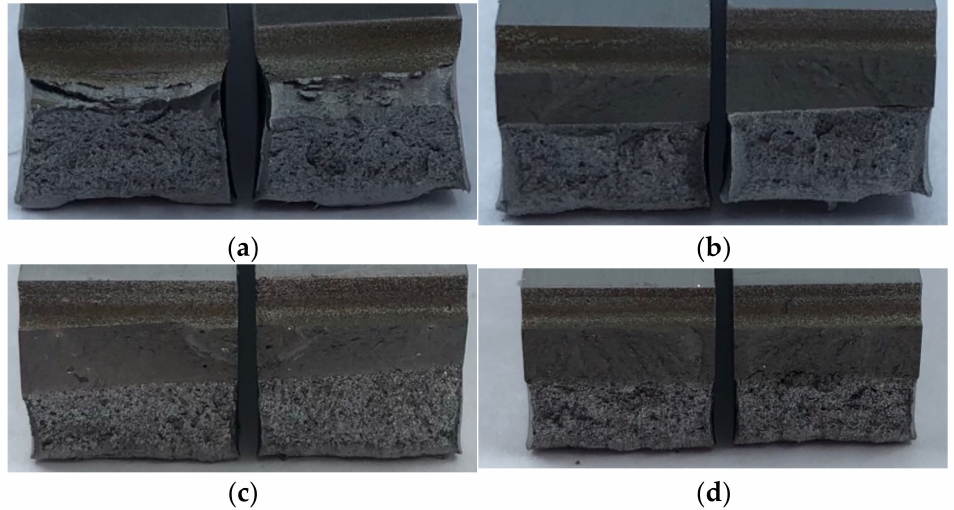
Figure 12. Fracture specimen after the Charpy test: ( a ) C-SCM420, ( b ) as-built (M2), ( c ) as-built (FeCrVMoW) and ( d ) as-built